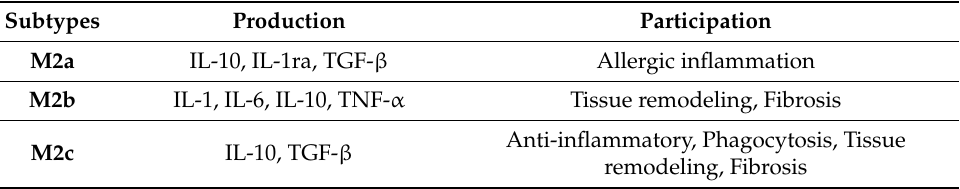
Table 2. The type of macrophages and their role in allergic